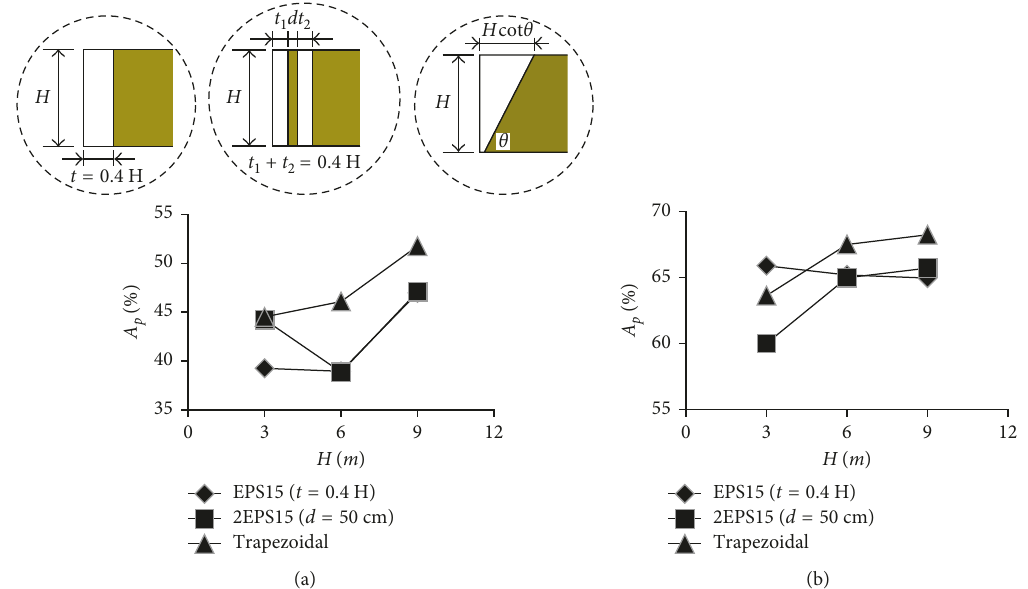
Figure 8: Effects of trapezoidal and rectangular geofoam panels on the reduction of wall forces: (a) yielding retaining wall and (b) nonyielding retaining wall.